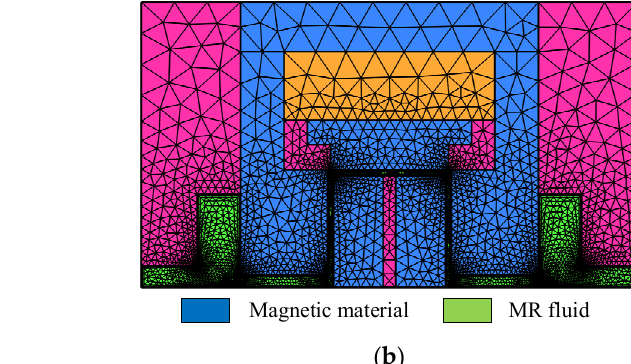
Figure 2. A 2D finite element model of the MR valve: ( a ) entity model, ( b ) meshed model. 1. End cover, 2. MR fluid, 3. Nonmagnetic ring, 4. Magnetic ring, 5. Damping disk, 6. Nonmagnetic disk, 7. Excitation coil, 8. Valve body, 9. Positioning plate.